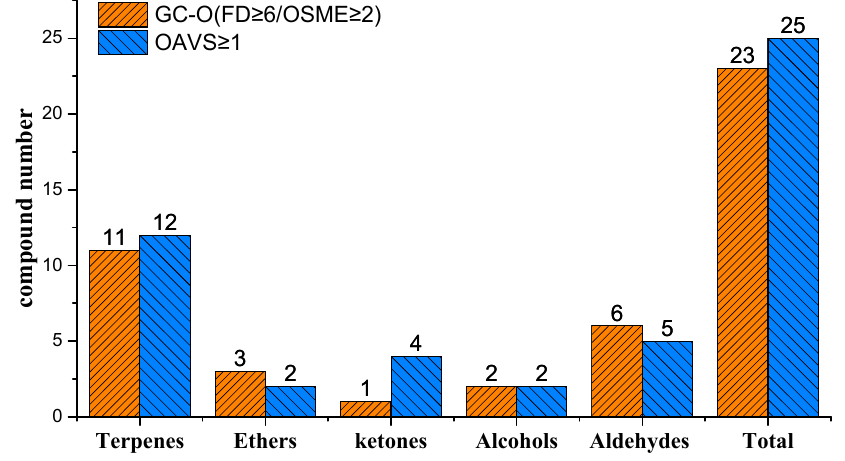
Figure 7. Comparison of GC-O (FD/OSME) and OAVs for aroma-active compounds.